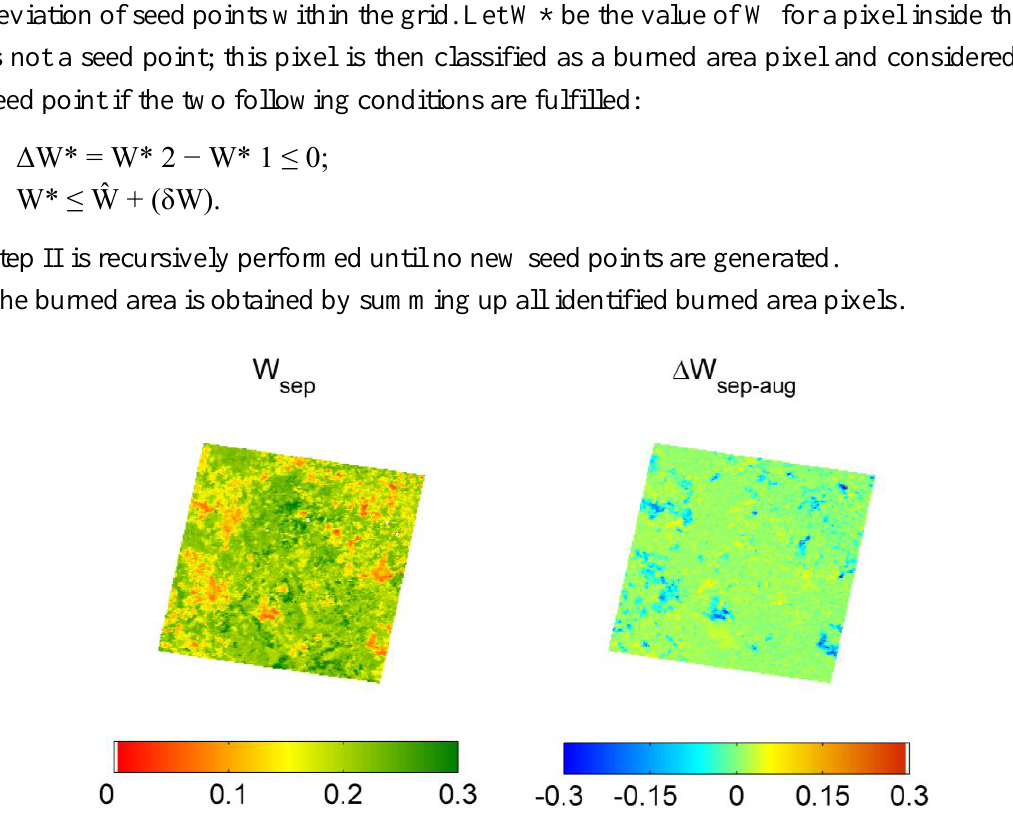
Figure 3. Maps of W for September 2010 composite ( left ) and of ΔW between September and August composites ( right ) over the study region shown in Figure